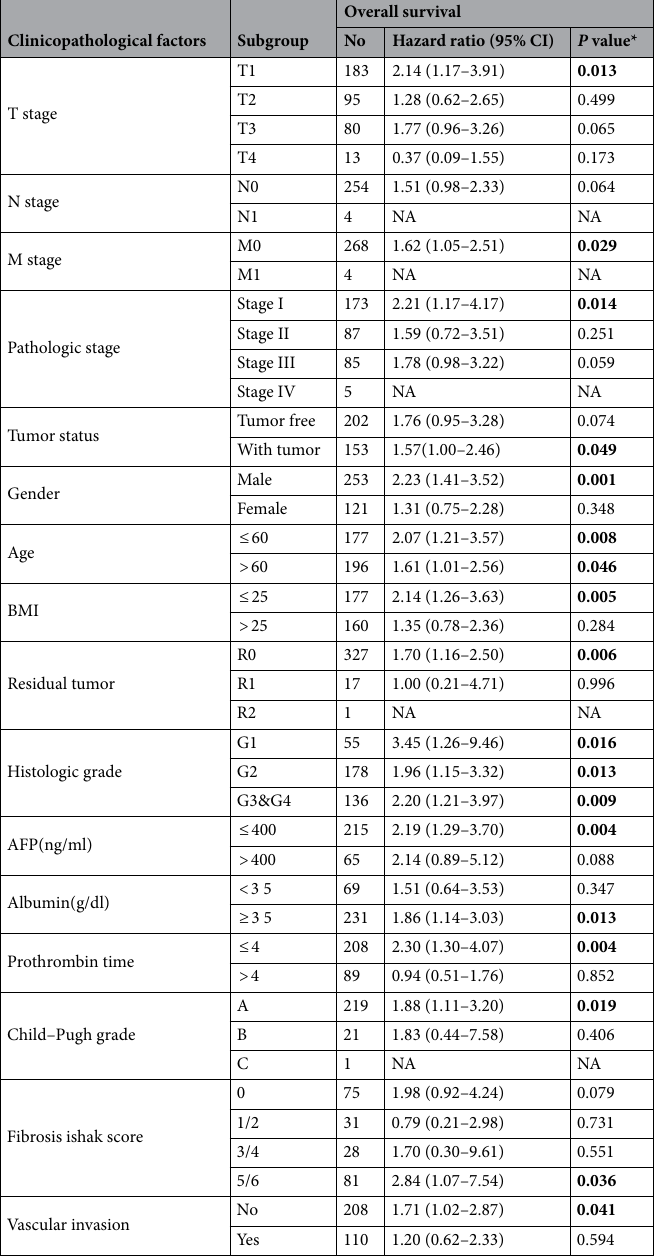
Table 3. Correlation of MMP1 expression and OS in hepatocellular carcinoma patients with different clinicopathological factors via Kaplan–Meier plotter. OS overall survival, CI confidence interval, NA